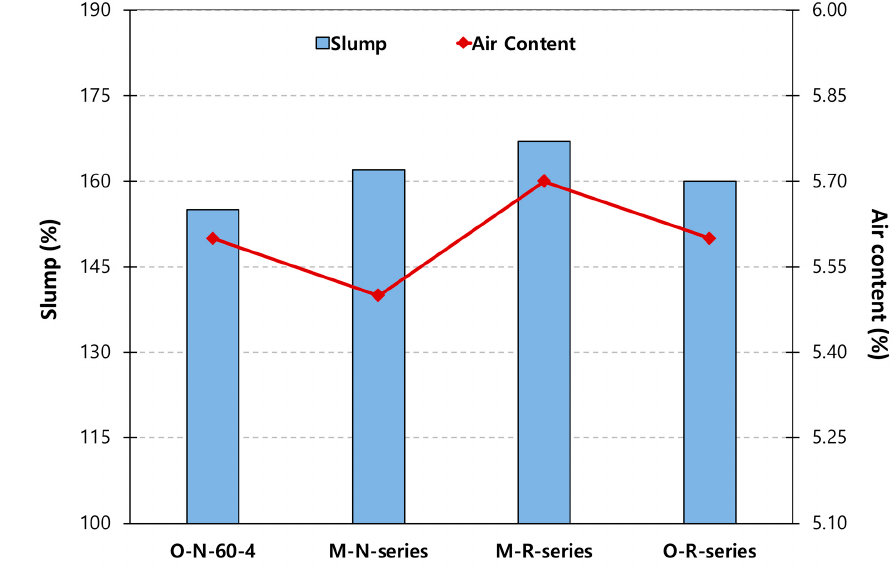
Figure 5. Fresh state properties (slump and air content).